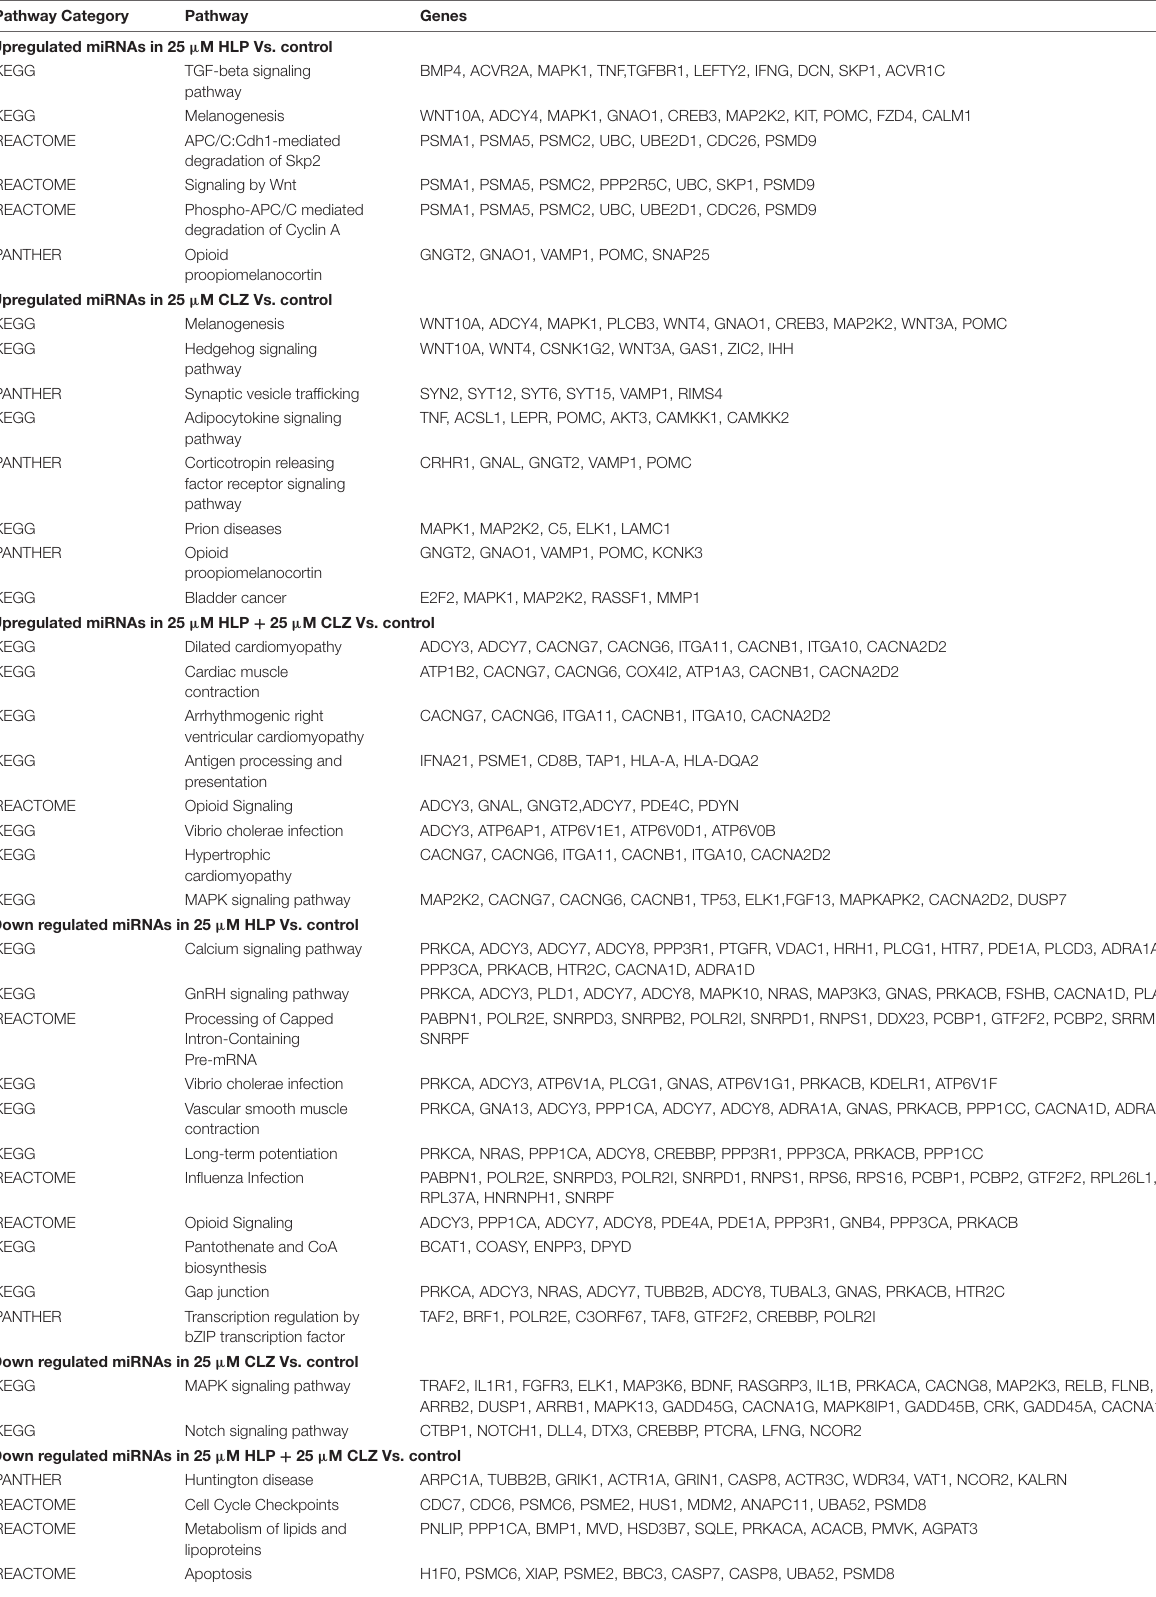
TABLE 4 | Pathway analysis of significantly differentially expressed miRNAs. Pathway Category Pathway Genes Upregulated miRNAs in 25 µ M HLP Vs. control KEGG TGF-beta signaling